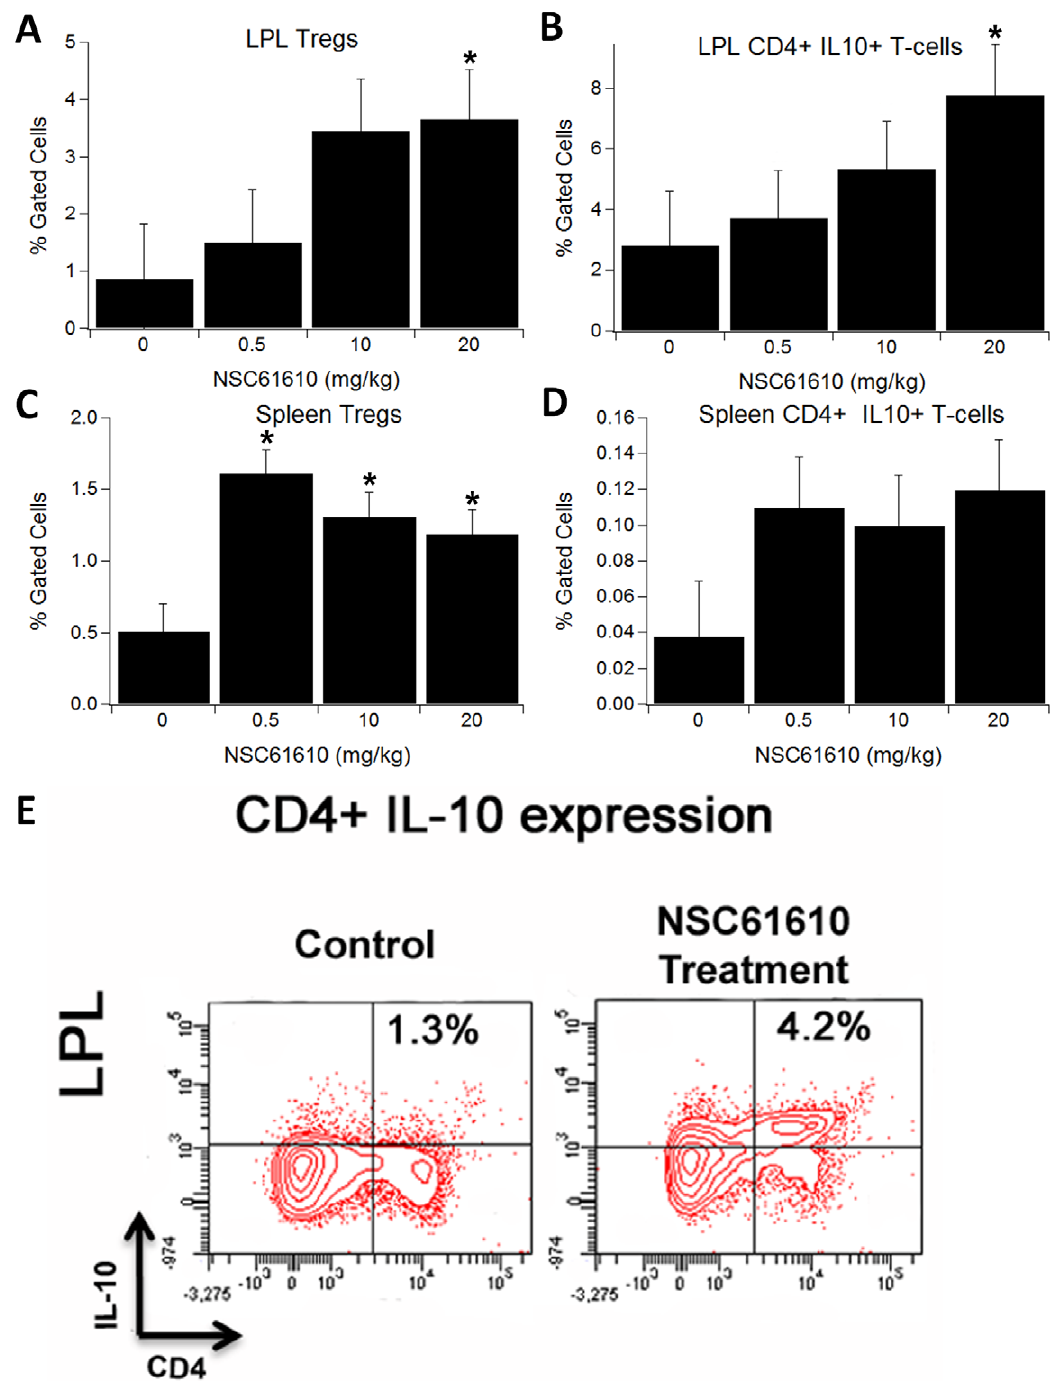
Figure 6. Oral treatment with NSC61610 on the distribution of immune cell subsets in colonic lamina propria and spleen. Colonic lamina propria lymphocytes (LPL, A, B, and E) and spleen (C and D), were immunophenotyped to identify regulatory T cells (Treg) and CD4 + IL-10 + T cell subsets through flow cytometry. Data are represented as mean 6 standard error (n=10). Bars with an asterisk indicate that a treatment is significantly different from its control ( P , 0.05